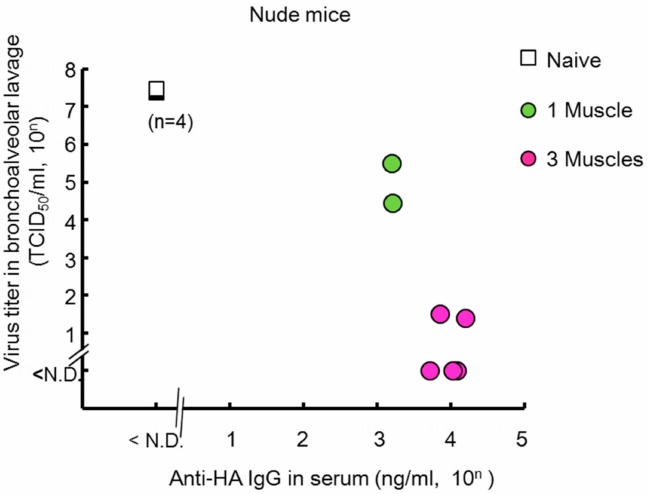
Figure 4. Long-prophylaxis against influenza virus infection in KSN/nu-nu nude mice that received electro-transfer of the plasmid encoding the neutralizing anti-HA mAb. The mice were challenged with 1000 TCID 50 /20 µ L of influenza virus (A/PR8) 130 days after the gene transfer as indicated. At 3 days post-infection, the serum and bronchoalveolar lavage specimens were obtained. The expression level of the anti-HA antibodies in serum and the viral titer were measured. N.D., not detected. Data were analyzed using a non-parametric Kruskal–Wallis test (Virus titer: p = 0.0013, Anti-HA IgG: p =